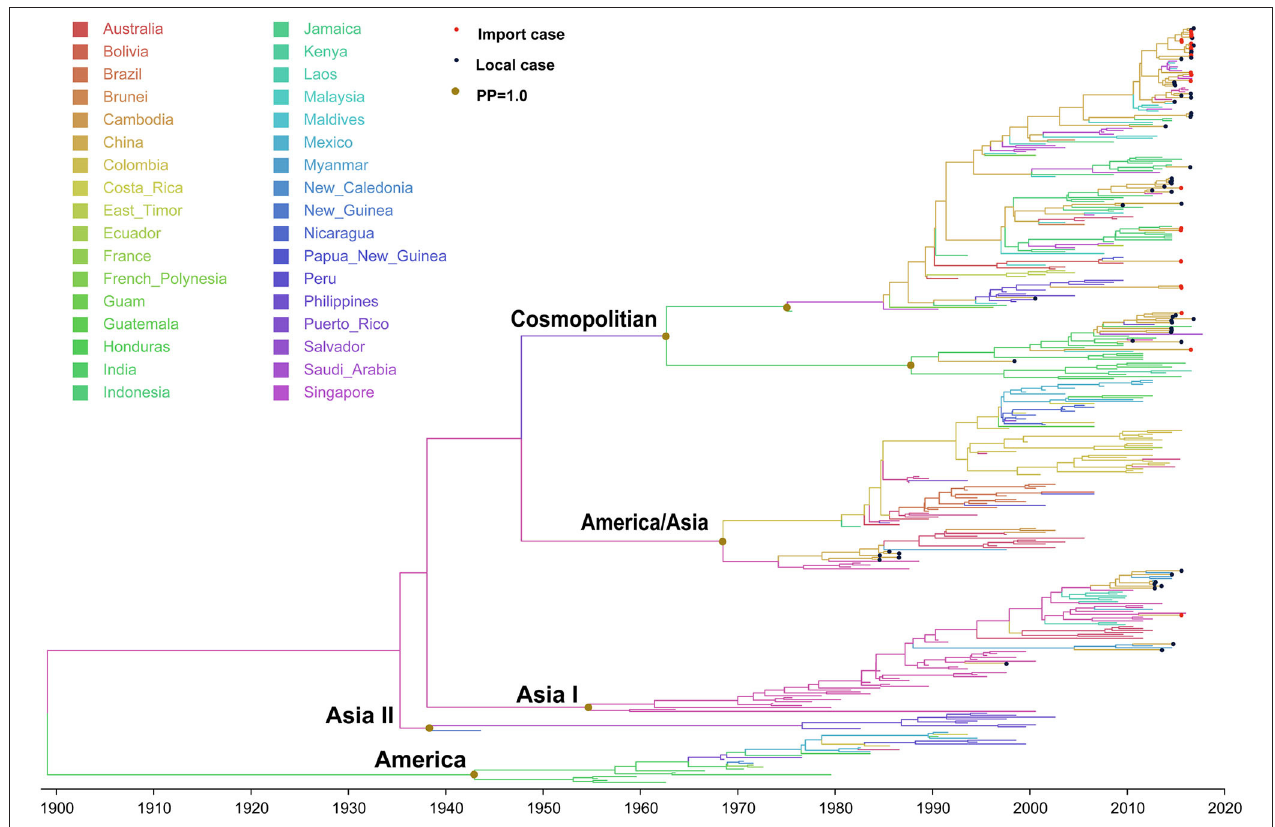
FIGURE 4 | Bayesian evolutionary tree of DENV 2. Source countries/regions of each strain and different genotypes of DENV 2 are presented by colors. Red dots represent imported cases, blue dots represent local cases, and brown dots are internal branch points with posterior probability = 1.0.